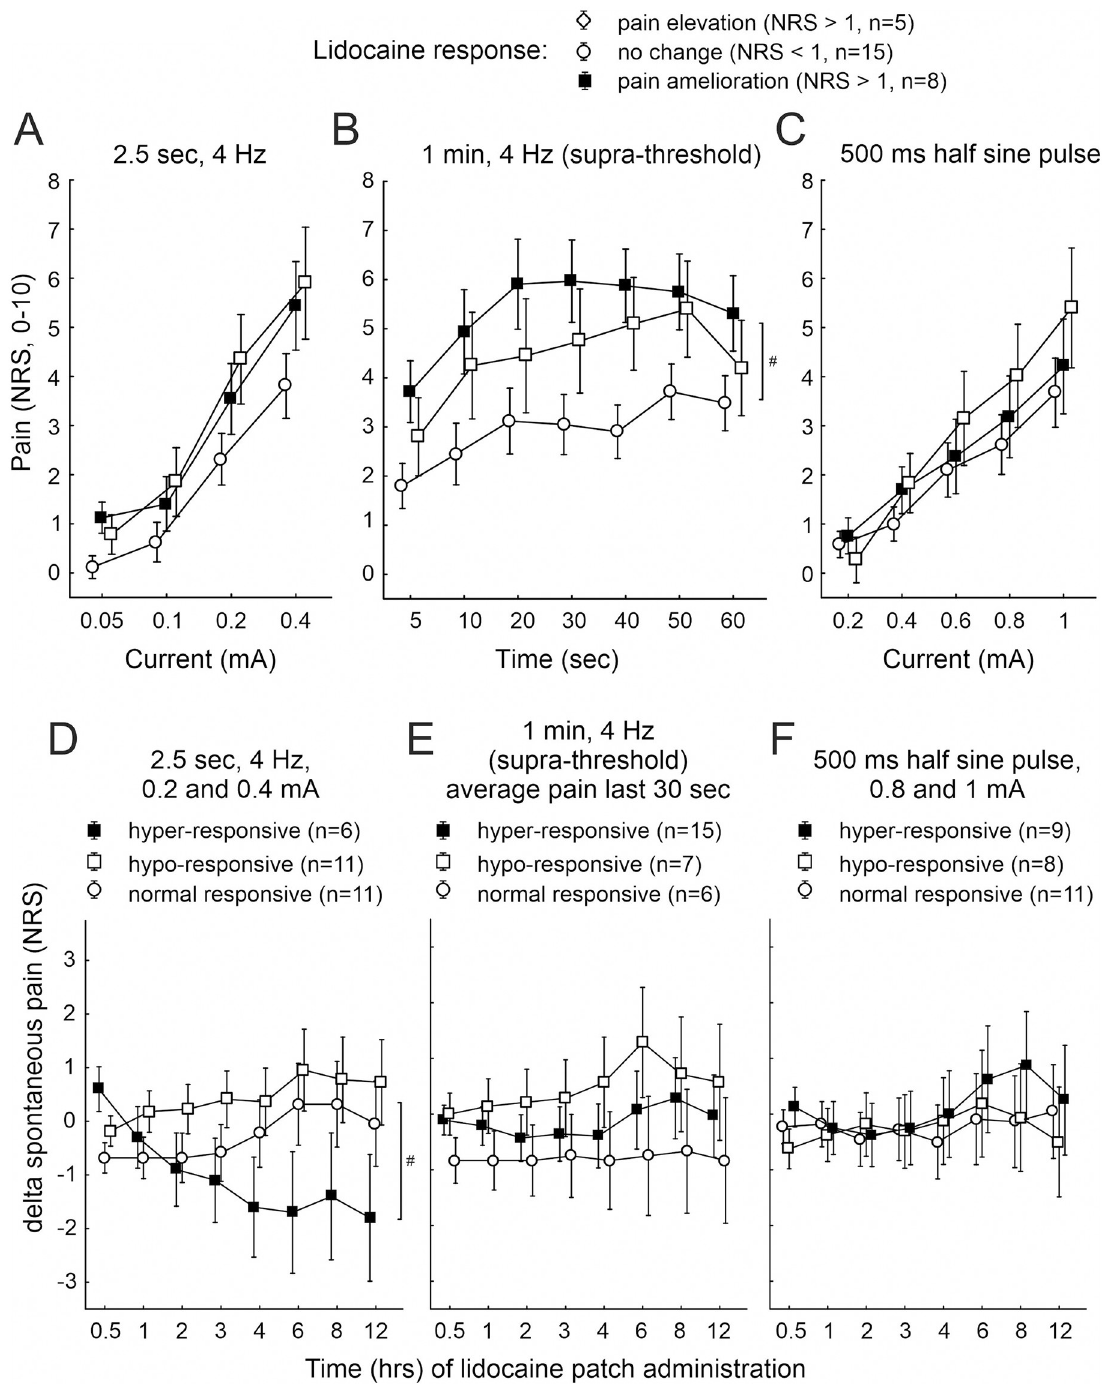
Fig 5. Comparison of electrically induced pain in lidocaine responding patients and lidocaine effects in patients sensitized to electrical stimulation. Electrically evoked pain (NRS, 0–10) recorded from neuropathic skin sites upon (A) 2.5 sec 4 Hz sinusoidal pulses of 0.05 to 0.4 mA, (B) 1 min 4 Hz sinusoidal pulses of supra-threshold intensity, and (C) 500 ms single half sine wave pulses of 0.2 to 1 mA in patients who reported about a reduction of acute (spontaneous) pain during 3 hours lidocaine patches (“pain amelioration”, solid squares), pain facilitation (“pain elevation”, open squares) or no alteration of acute pain (“no change”, open circles). Sinusoidal 1 min stimulation evoked significantly more pain in patients revealing a lidocaine effect (“pain amelioration”) than in patients without a response (p < 0.03, ANOVA, marked by hash symbol). Alteration of acute (spontaneous) pain due to a lidocaine 5% patch (delta NRS, -10 to 10) during 0.5–12 hours of application depicted in patients with “hyper-responsive” (solid squares”), “hypo-responsive” (open squares)